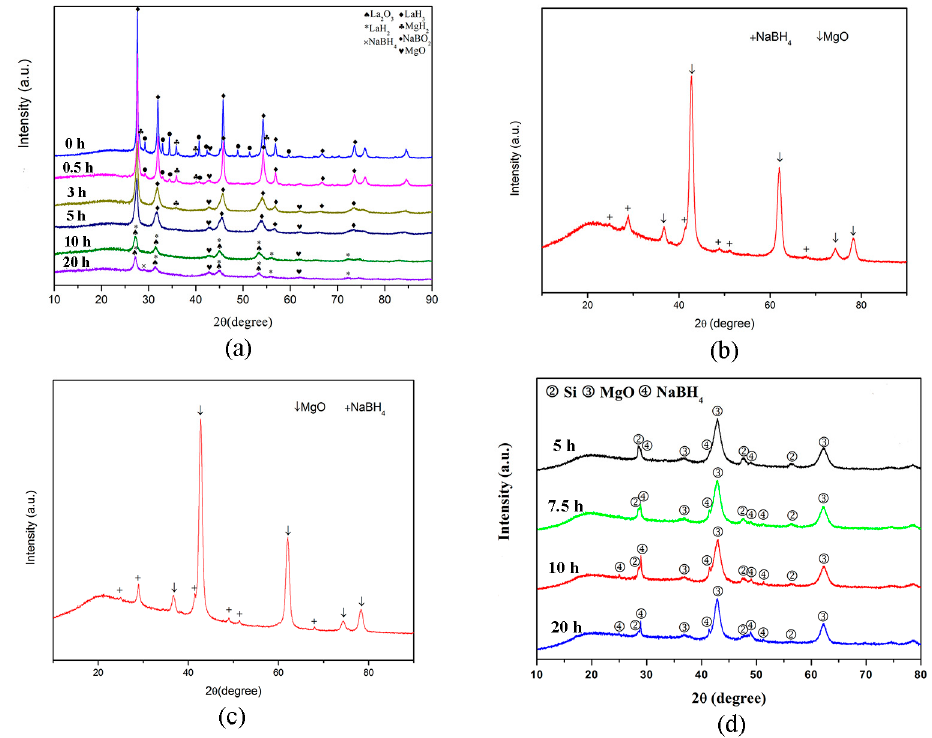
Figure 1. ( a ) XRD patterns of the NaBO 2 –Mg 3 La hydride mixture and the product after ball milling the NaBO 2 –Mg 3 La hydride mixture. ( b ) XRD pattern of products via ball-milling the mixture of NaBO 2 · 2H 2 O and MgH 2 in 1:5.5 mol ratio for 15 h. ( c ) XRD pattern of products via ball-milling the mixture of NaBO 2 · 2H 2 O and Mg in 1:5 mole ratio for 15 h. ( d ) XRD patterns of the products after ball milling Mg 2 Si and NaBO 2 · 2H 2 O mixtures (in 2:1 mol ratio).